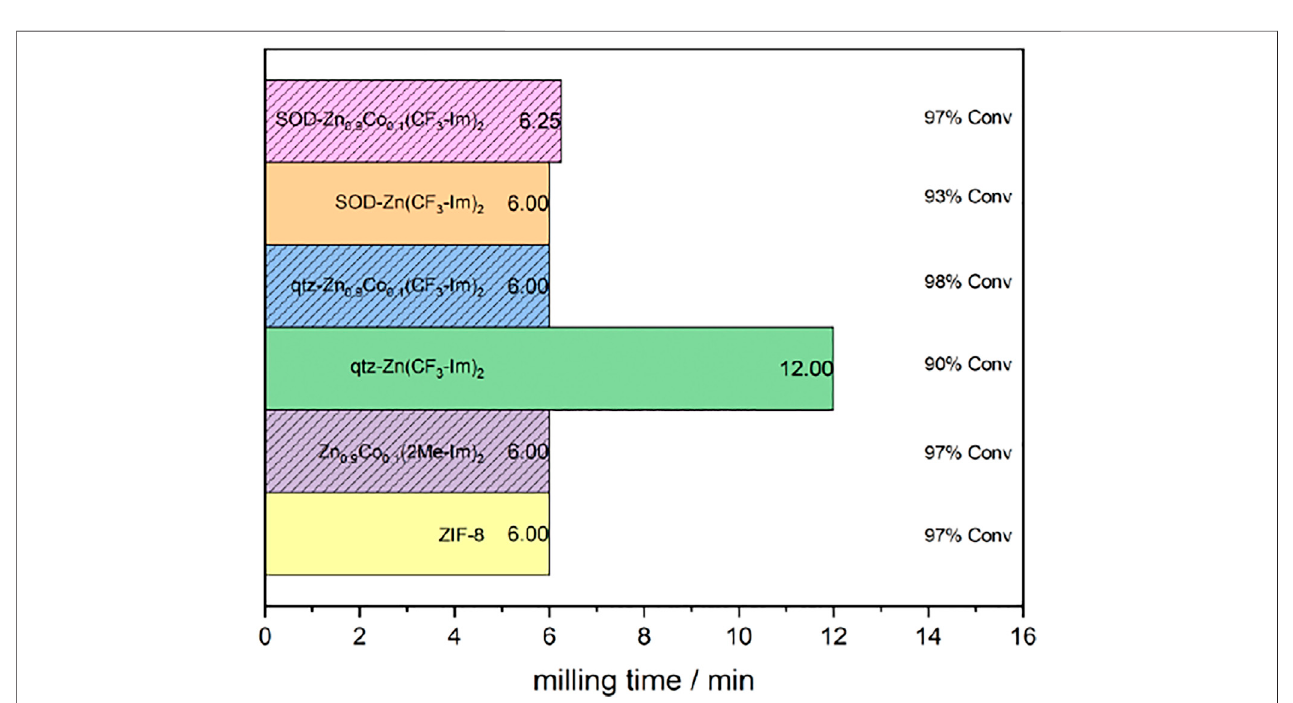
FIGURE11| MillingtimesandconversionratesforthesynthesisofZIF-8,Zn 0.9 Co 0.1 (2Me-Im) 2 (bothinSOD-topology),aswellasZn(CF 3 -Im) 2 andZn 0.9 Co 0.1 (CF 3 - Im) 2 (qtz and SOD).